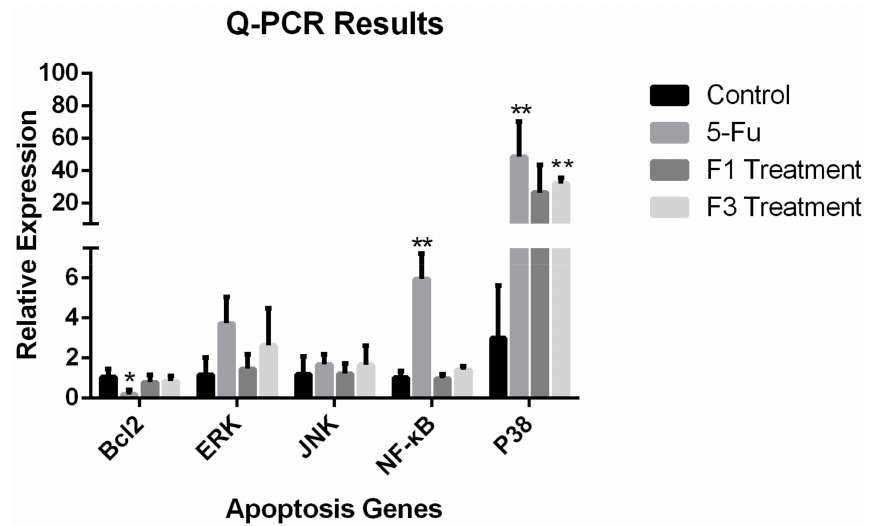
Figure 10. The relative expression level of apoptosis-related genes. (comparing with control group, * p ≤ 0.05; ** p ≤ 0.01).